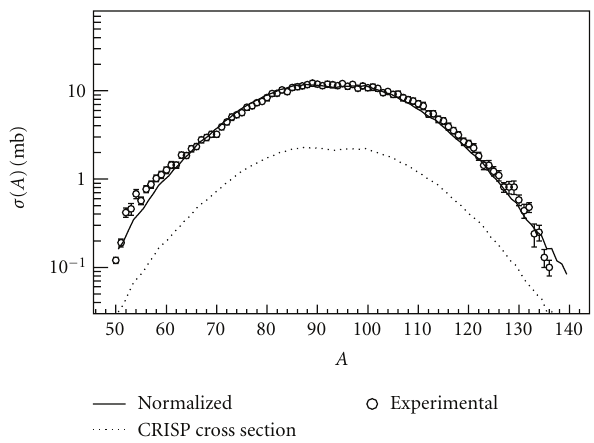
Figure 3: Cross sections for fragments produced in the fission of 208 Pb induced by 500 MeV protons as a function of